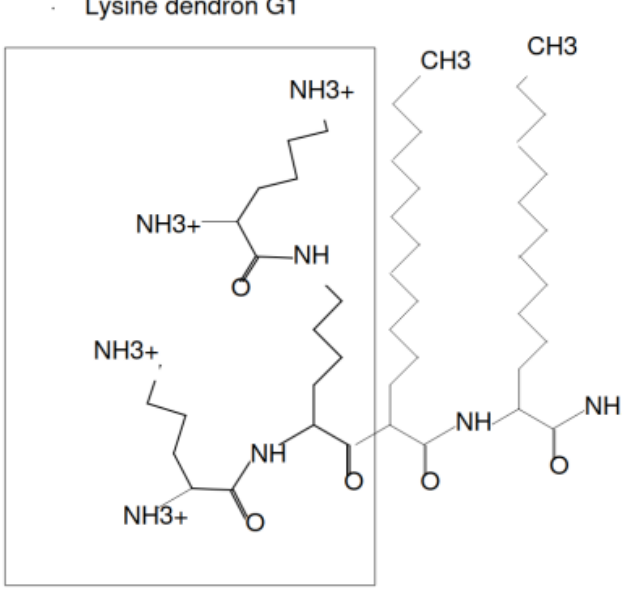
Figure 13. The chemical structure of the hybrid molecule (surfactant) consisting of a lysine dendron G = 1 with two hydrophobic tails t = 2. The number of charged groups NH + number of hydrophobic segments CH 2 in a tail is N t =